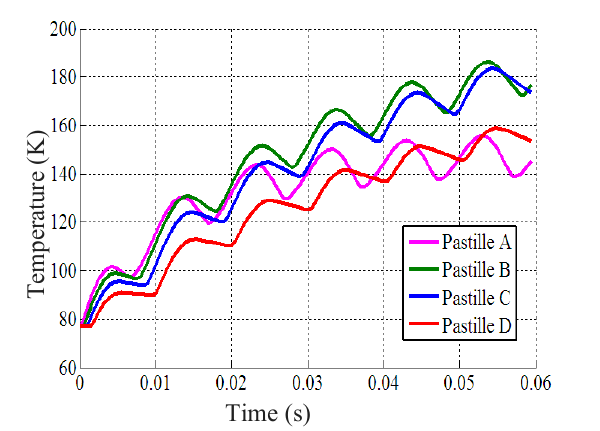
Figure 8: The variation of the temperature in the different pellets as a function of time.